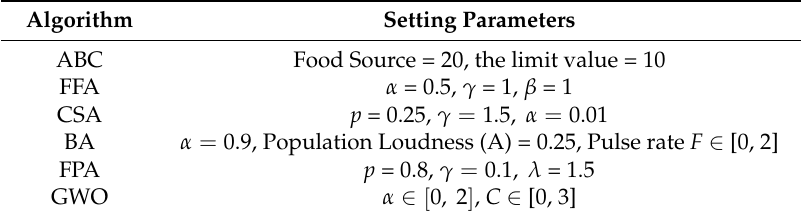
Table 3. Setting parameters associated with each